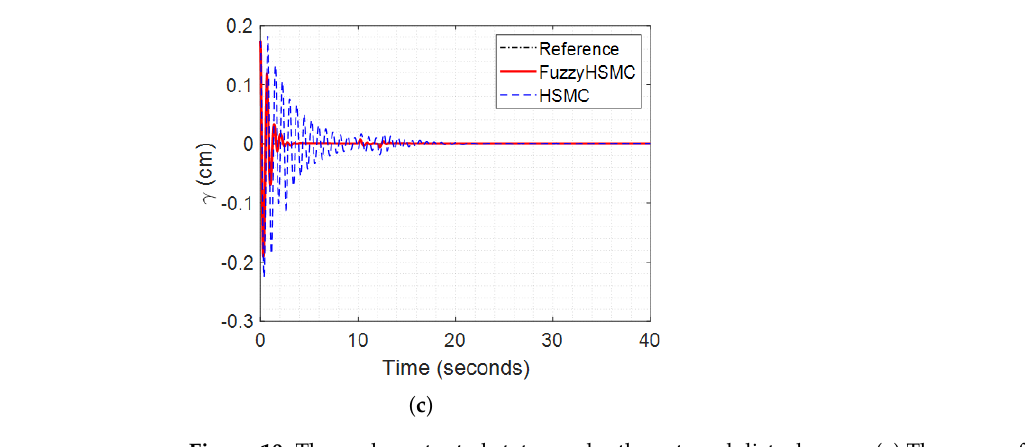
Figure 10. The under-actuated states under the external disturbances. ( a ) The sway of the payload in Oxz , ξ x ( t ) . ( b ) The sway of the payload in Oyz , ξ y ( t ) . ( c ) The oscillation of the hoisting cable in the cable direction, γ ( t )